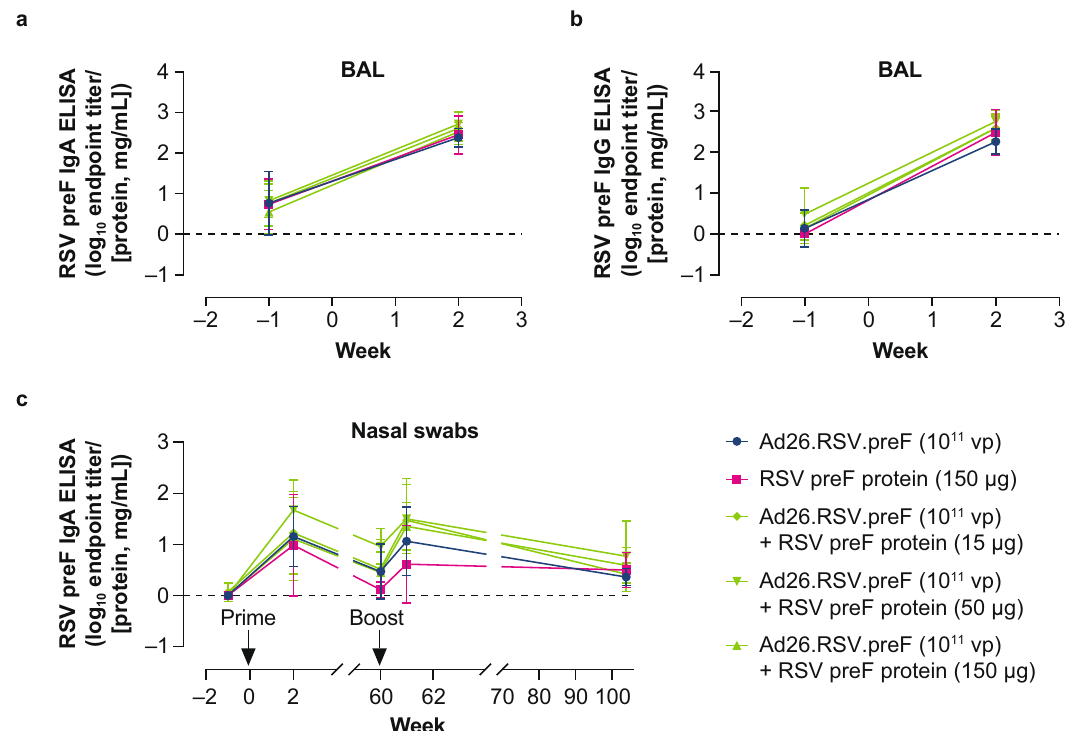
Fig. 6 RSV preF IgA and IgG titers measured in nasal swabs and BAL of African green monkeys. African green monkeys were immunized as described in Fig. 5. RSV preF IgA ( a ) and IgG ( b ) antibody-binding titers, expressed as endpoint titer (ELISA) divided by total protein concentration measured at OD280, in BAL samples obtained before immunization and after immunization at Week 2. No BAL samples were collected after boost immunization. RSV preF IgA ELISA titers ( c ) were measured in nasal swabs obtained before immunization and at Weeks 2, 60, 61, and 104. Error bars indicated SD. Ad26, adenovirus type 26; BAL, bronchoalveolar lavage; ELISA, enzyme-linked immunosorbent assay; IgA, immunoglobulin A; IgG, immunoglobulin G; preF, prefusion conformation-stabilized RSV F protein; RSV, respiratory syncytial virus; SD, standard deviation; vp, viral